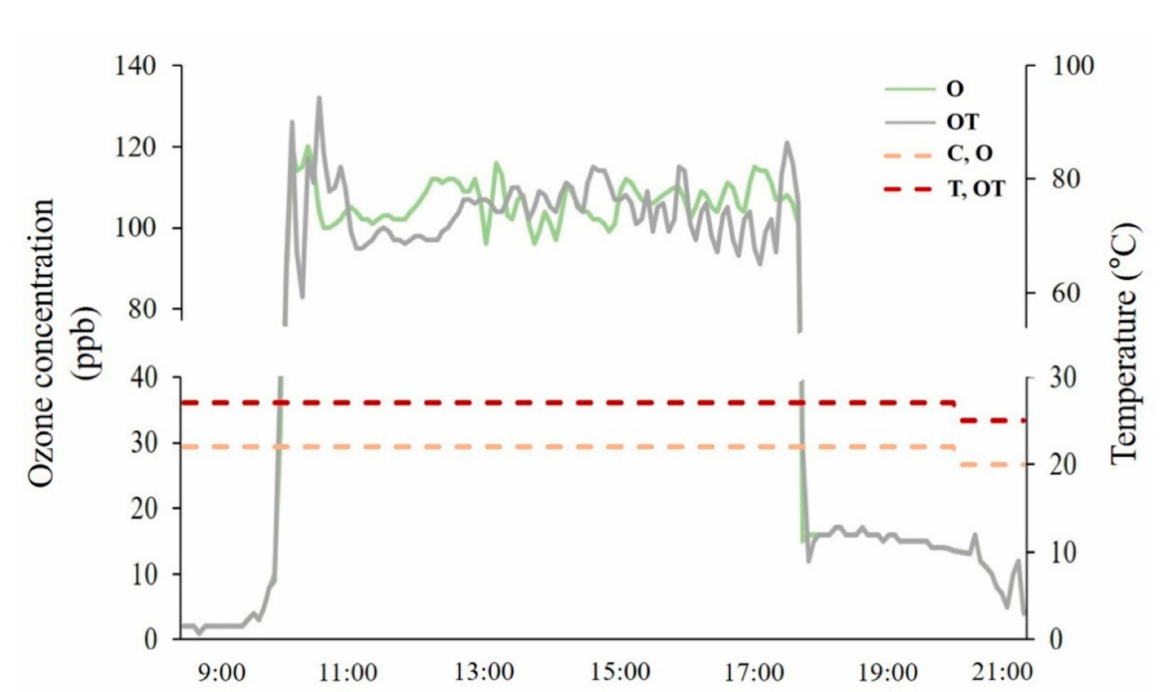
Figure 1. Daily variation in ozone concentration (solid line) and temperature (dash line) in each treatment chamber. C: optimal temperature + ambient O 3 ; T: supraoptimal temperature + ambient O 3 ; O: optimal temperature + elevated O 3 ; OT: supraoptimal temperature + elevated O 3